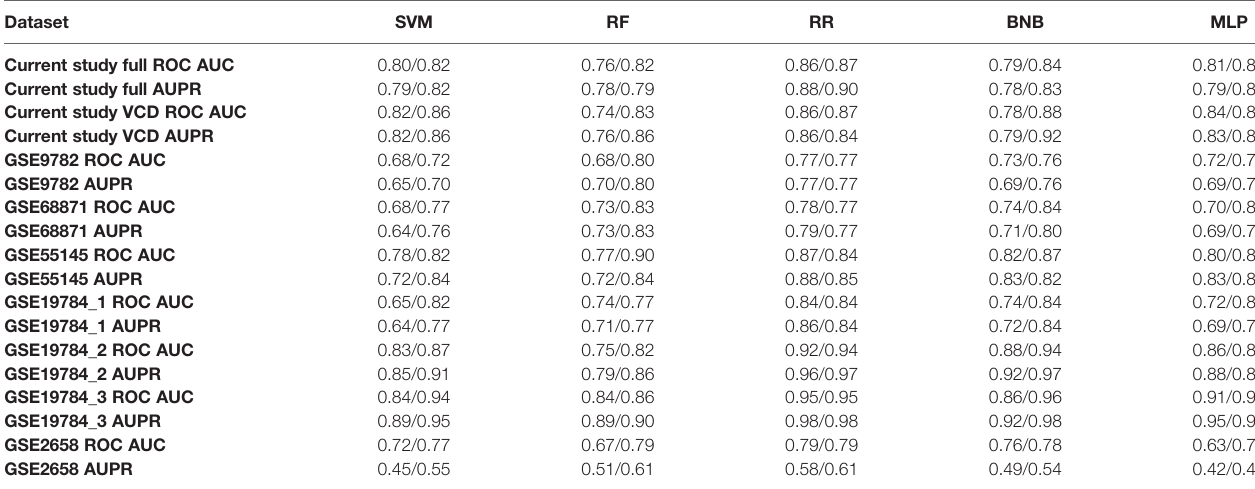
TABLE 5 | Best ROC AUC and AUPR (precision-recall AUC) values obtained for good versus poor responder classi fi ers built using different ML methods without/with FloWPS for different MM annotated expression datasets. Dataset